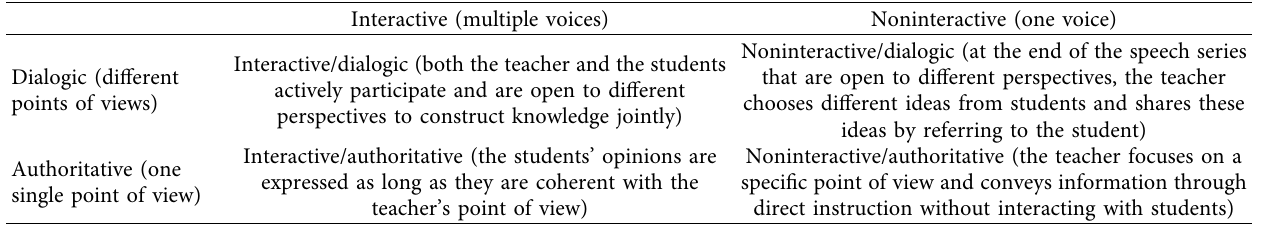
Table 1: Four classes of the communicative approach